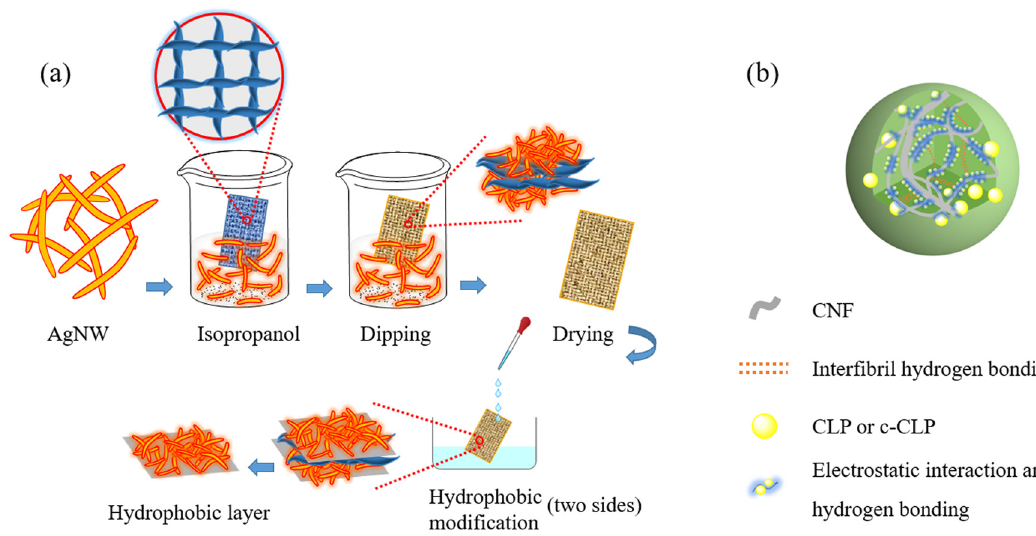
Figure 8: Interaction of constituents of composite papers ( a ) H - AgNW/CNF paper, ( b ) CNF and CLP or c - CLPs